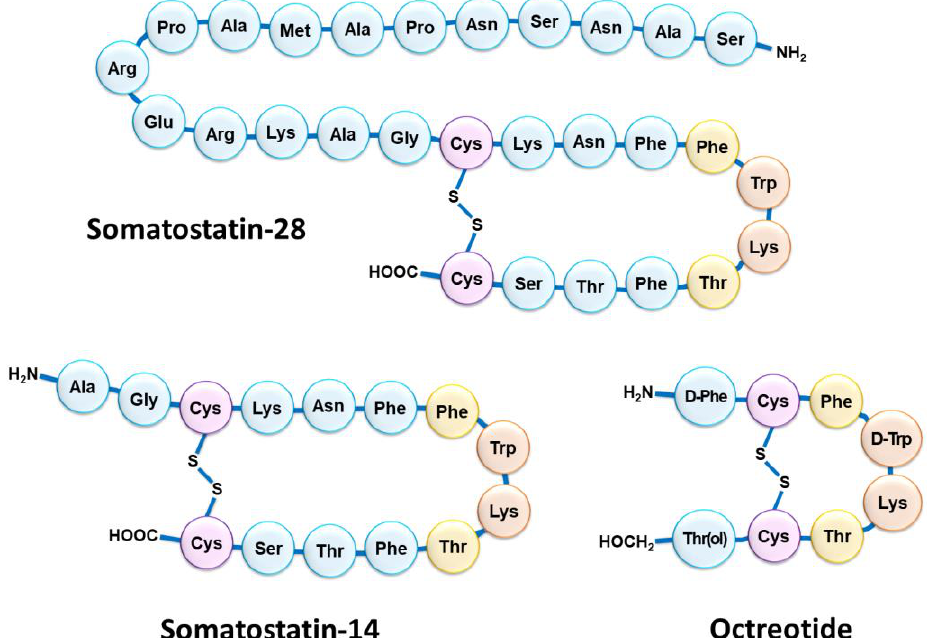
Figure 1. Schematic structure of the two natural isoforms of somatostatin (SS-14 and SS-28) and octreotide. The amino acid residues Cys (purple) form an intramolecular disulfide bridge; the amino acid residues Trp and Lys (orange) included in a β -turn are necessary for biological activity; the nearby amino acid residues Phe and Thr (yellow) are in favor of good biological activity but accept slight modulation.